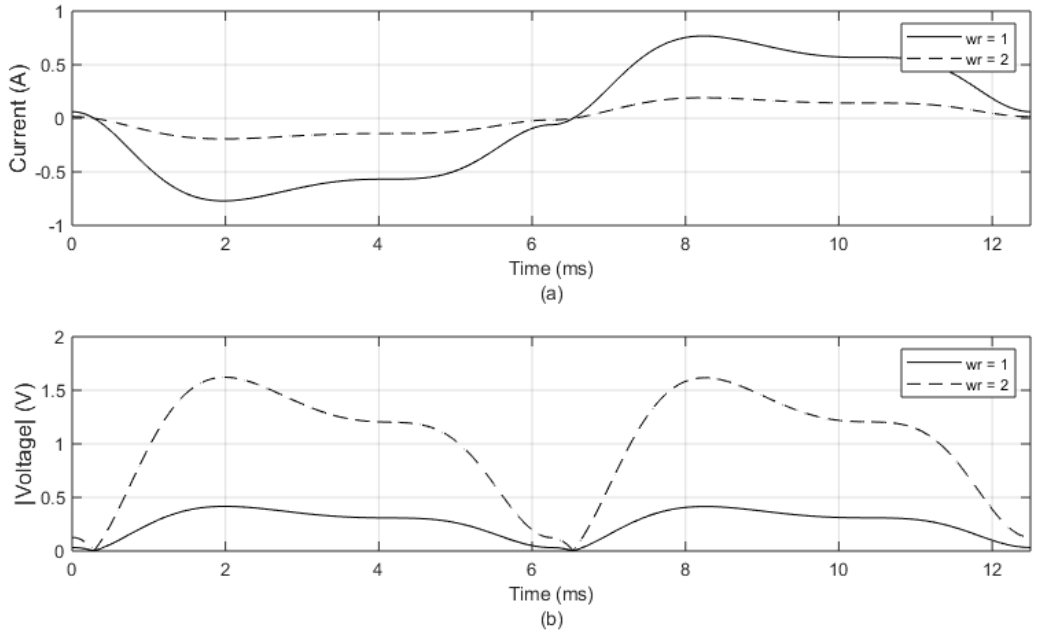
Figure 6. ( a ) Current and ( b ) voltage requirements of the actuator when the ’winding ratio’ is